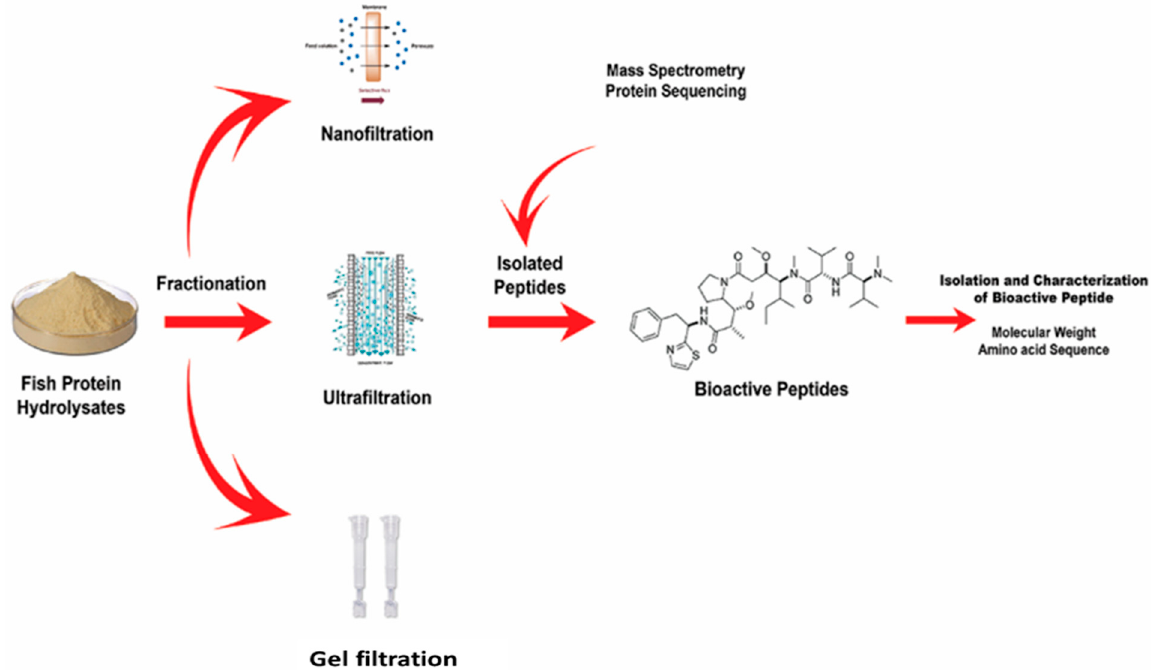
Figure 8. Structural characterization of fish-based bioactive peptides was determined initially by purification through nano-filtration, ultra-filtration, and gel-filtration; the purified peptides were further characterized based on the molecular weight using high-performance liquid chromatography mass spectrometry and the protein sequence was determined using liquid chromatography mass spectrometry .